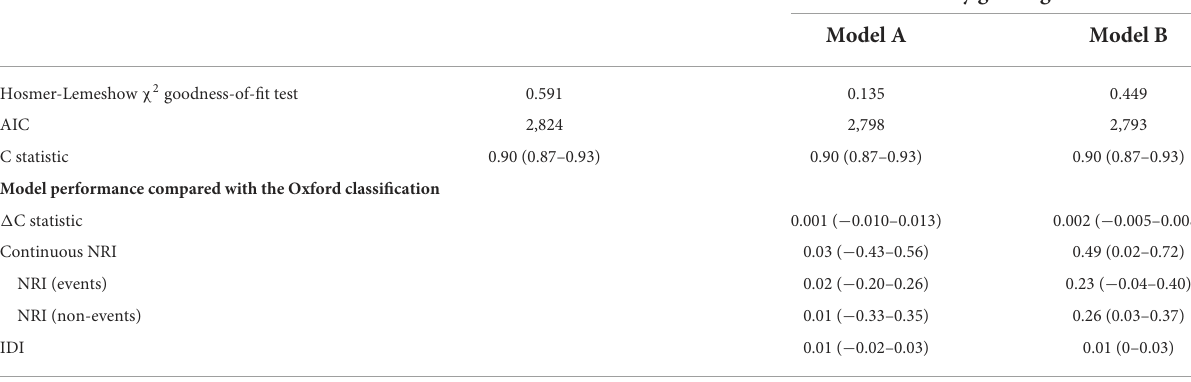
TABLE 7 Prediction performance of the chronicity grading models compared with the oxford classification model a .